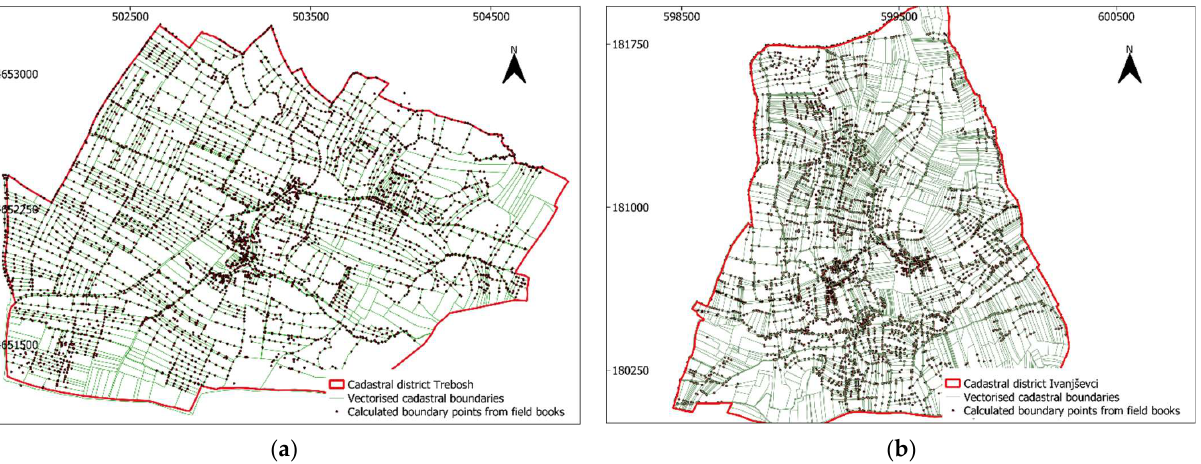
Figure 5. Calculated coordinates of land boundary points from field books overlaid on vectorised land boundaries; ( a ) Cadastral district of Trebosh, North Macedonia; ( b ) Cadastral district Ivanjševci, Slovenia.